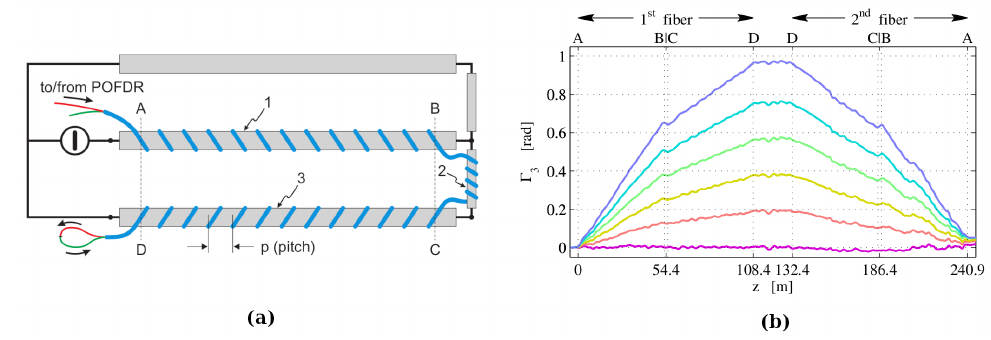
Figure 7. Polarimetric distributed measurement of electric current. ( a ) Sketch of the electrical circuit used to perform the experiment. The parallel conductors AB and CD have diameter 9cm, are 20m long and about 1.2m apart; fibers are coiled with a pitch of 10cm. ( b ) Faraday rotation measured along the concatenated fibers for current intensities ranging from 0kA (lowest curve) to 2.5kA (highest curve) in steps of 0.5kA (Adapted from Ref.